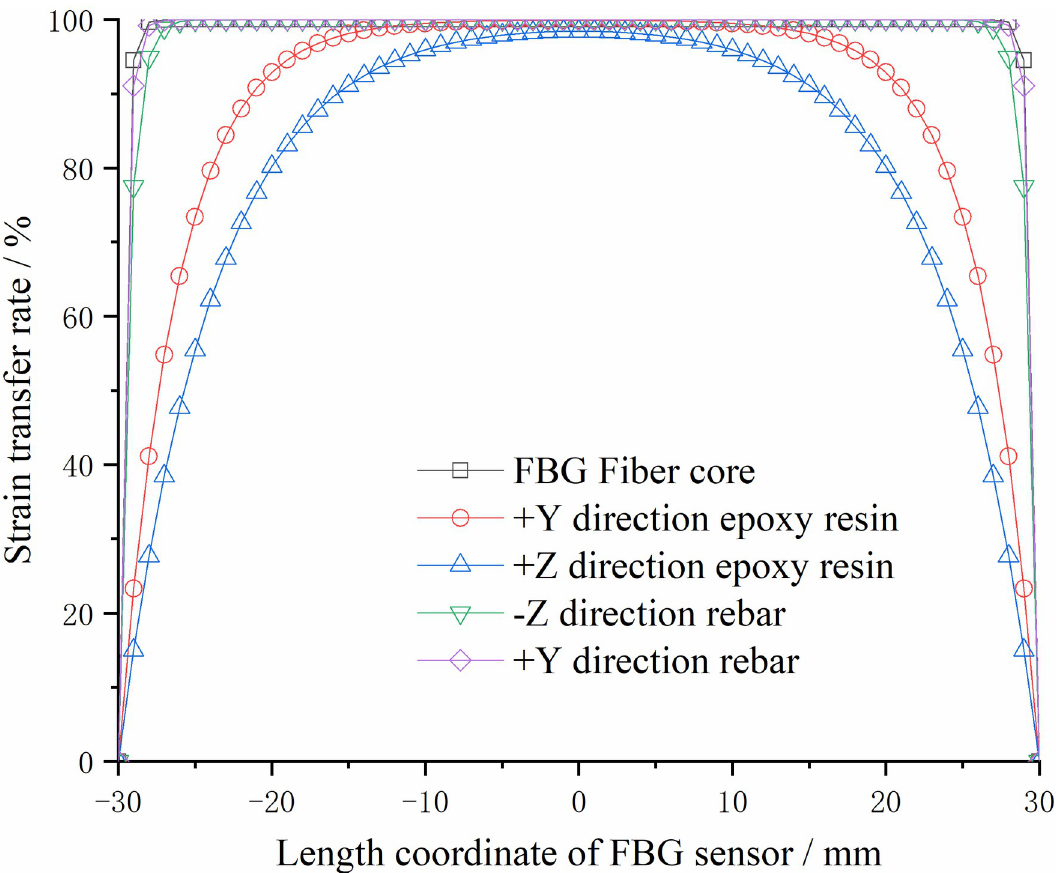
Fig 4. Relationship curve between strain transfer rate of steel substrate and length